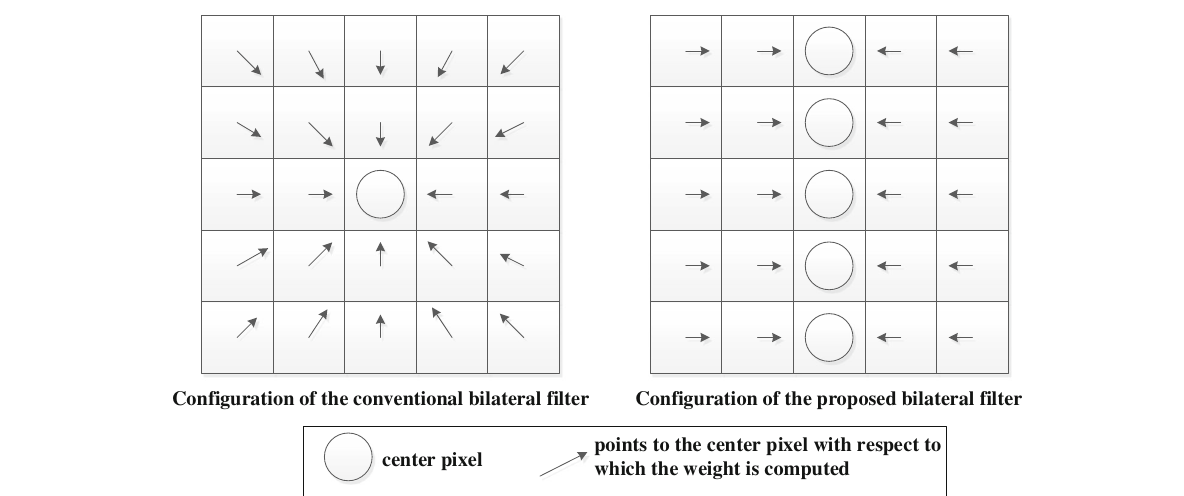
Fig. 1 Difference between the conventional bilateral filter and the proposed bilateral filter. Left: weights for the conventional bilateral filter are computed with one single center pixel as the reference. Right: weights of the proposed bilateral filter are computed with multiple center pixels as the